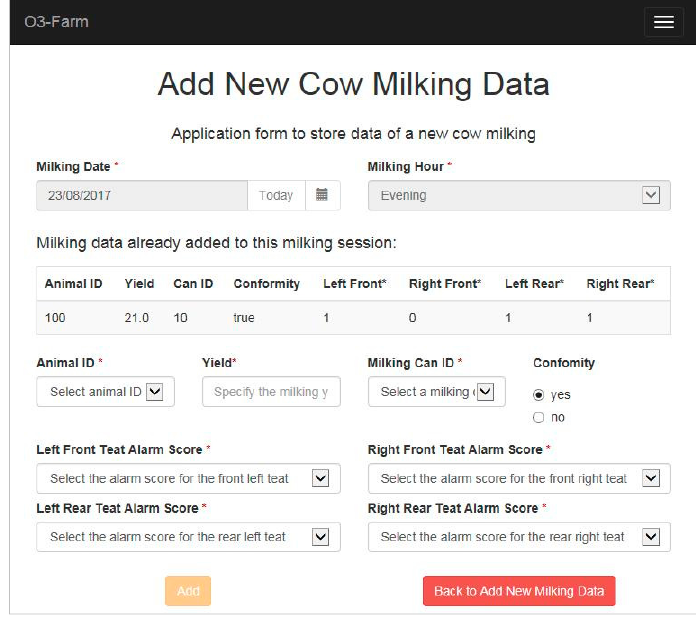
Figure 9. Form available for milkers to add milking data after a milking session.